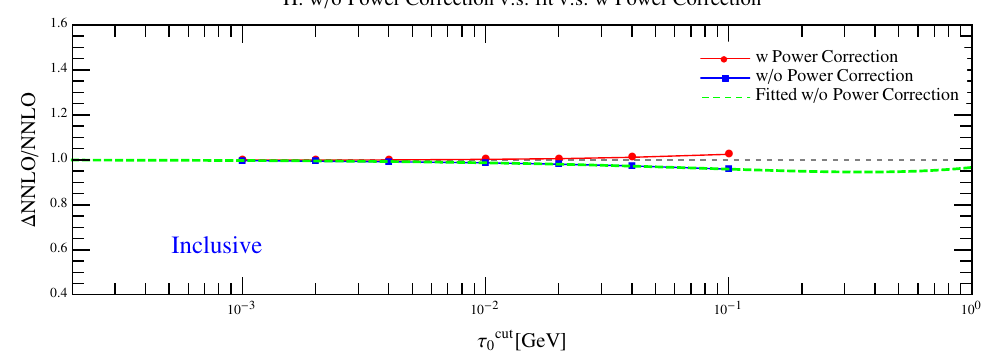
Figure 4 . A comparison of the NNLO coe(cid:14)cients for inclusive ggH production at the LHC using N -jettiness subtraction with and without power corrections, normalized to the exact NNLO